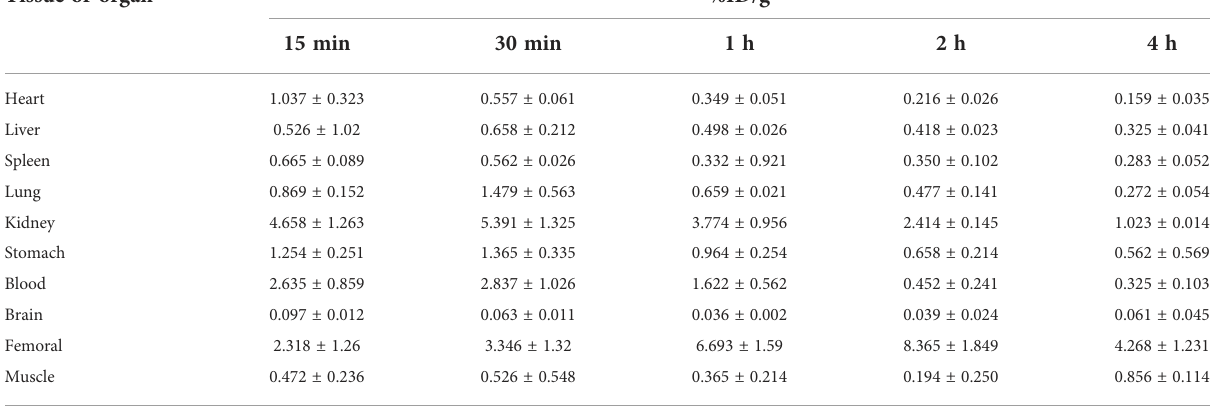
TABLE 2 In vivo distribution of 68 Ga-DOTA-IBA in mice from 15 min – 4 h (n = 4). Tissue or